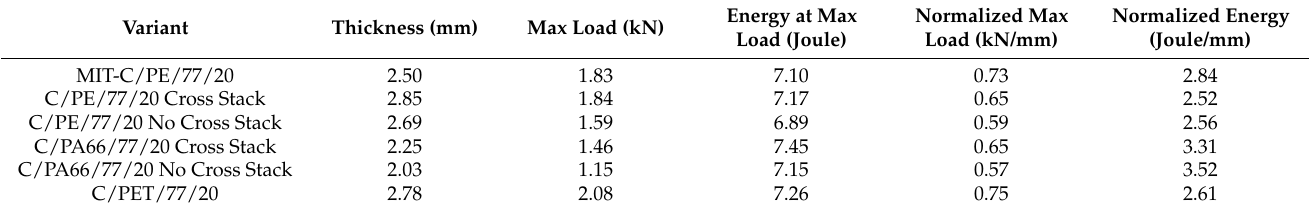
Table 13. Low-velocity impact results at low-impact energy (5 J).